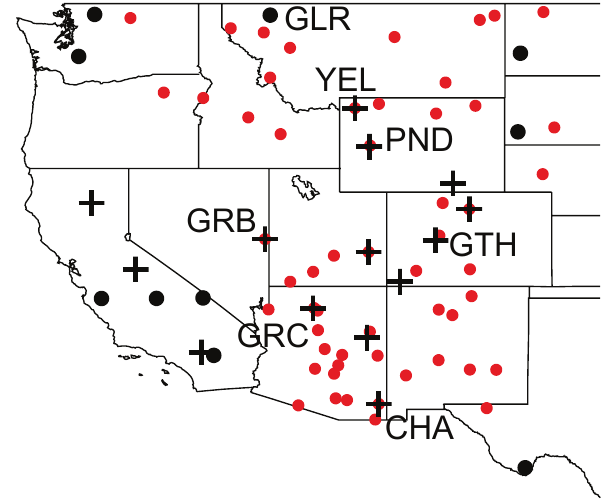
Figure 4. CASTNet ozone monitoring sites (black circles and pluses) in the western US used for 2006–2008 model evaluation. Pluses denote sites above 1.5km altitude. Sites discussed in the text are labeled: GLR, Glacier National Park (NP), Montana; YEL, Yel- lowstone NP, Wyoming; PND, Pinedale, Wyoming; GTH, Gothic, Colorado; GRB, Great Basin NP, Nevada; GRC, Grand Canyon NP, Arizona; CHA, Chiricahua National Monument (NM), Arizona. Also shown are the IMPROVE particulate matter monitoring sites (red circles) in the Intermountain West used for Fig.